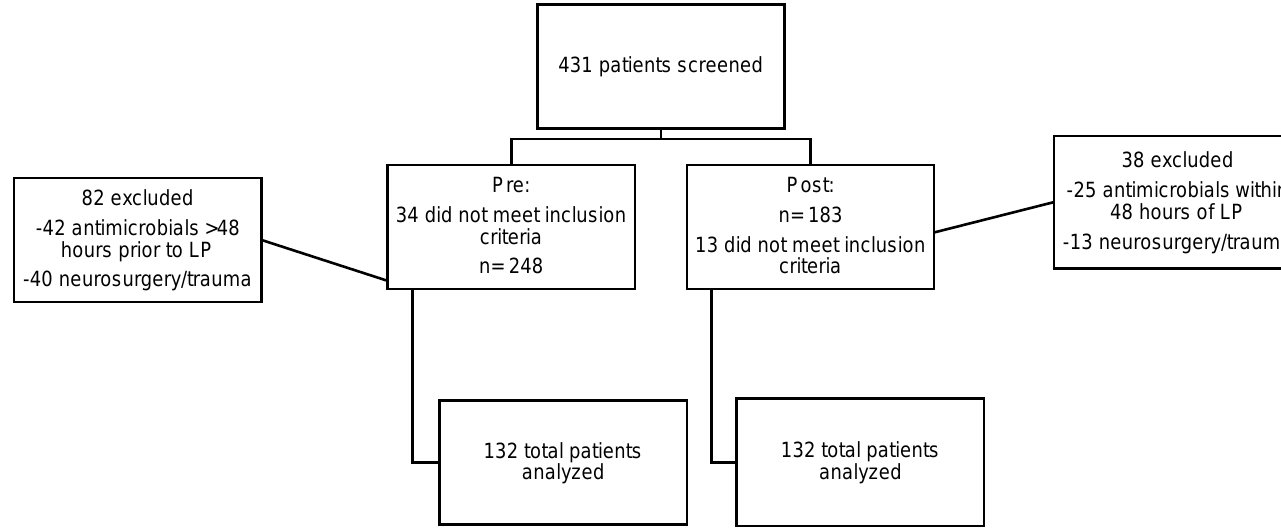
Figure 1. Study Flow